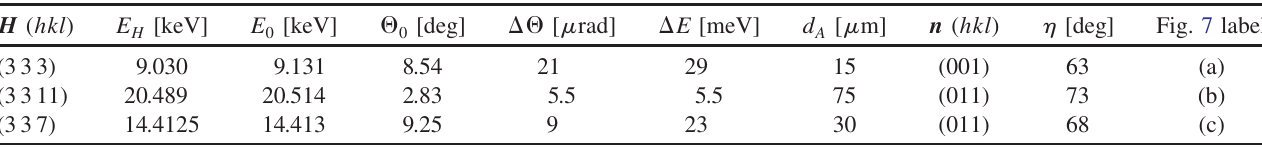
TUNABLE OPTICAL CAVITY FOR AN X-RAY FREE- . . TABLE I. Parameters of the diamond crystals in the four-bounce x-ray cavity (Fig. 6) optimized for the following applications: (a) 0.1- to 1-meV IXS with angular dispersive analyzers [11,27,28]; (b) 1 meV IXS with segmented spherical Si(11 11 9) analyzers [26]; (c) 0.1- to 1-meV 57 Fe NRS [21,22]. The thickness d A of crystal A is chosen to assure 4% out-coupling of x rays from the cavity.